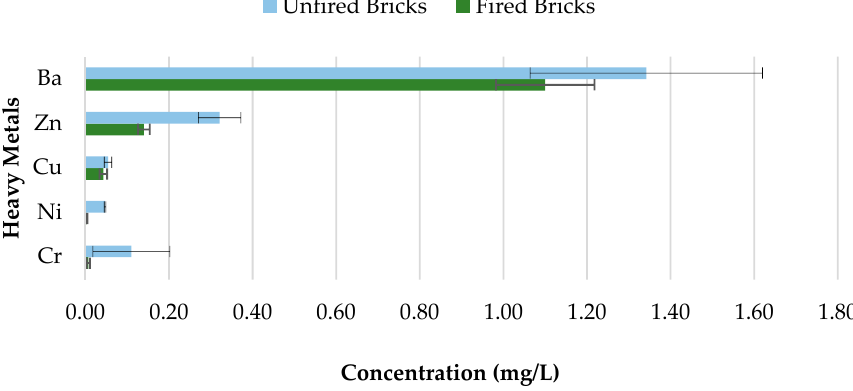
Figure 18. Heavy metal concentration of 0.5% CB content bricks before and after firing.